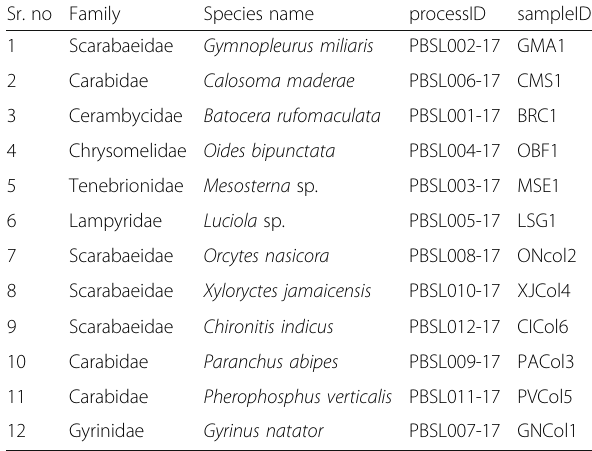
Table 2 List of species with their families submitted to BOLD v.4 along with their processID and